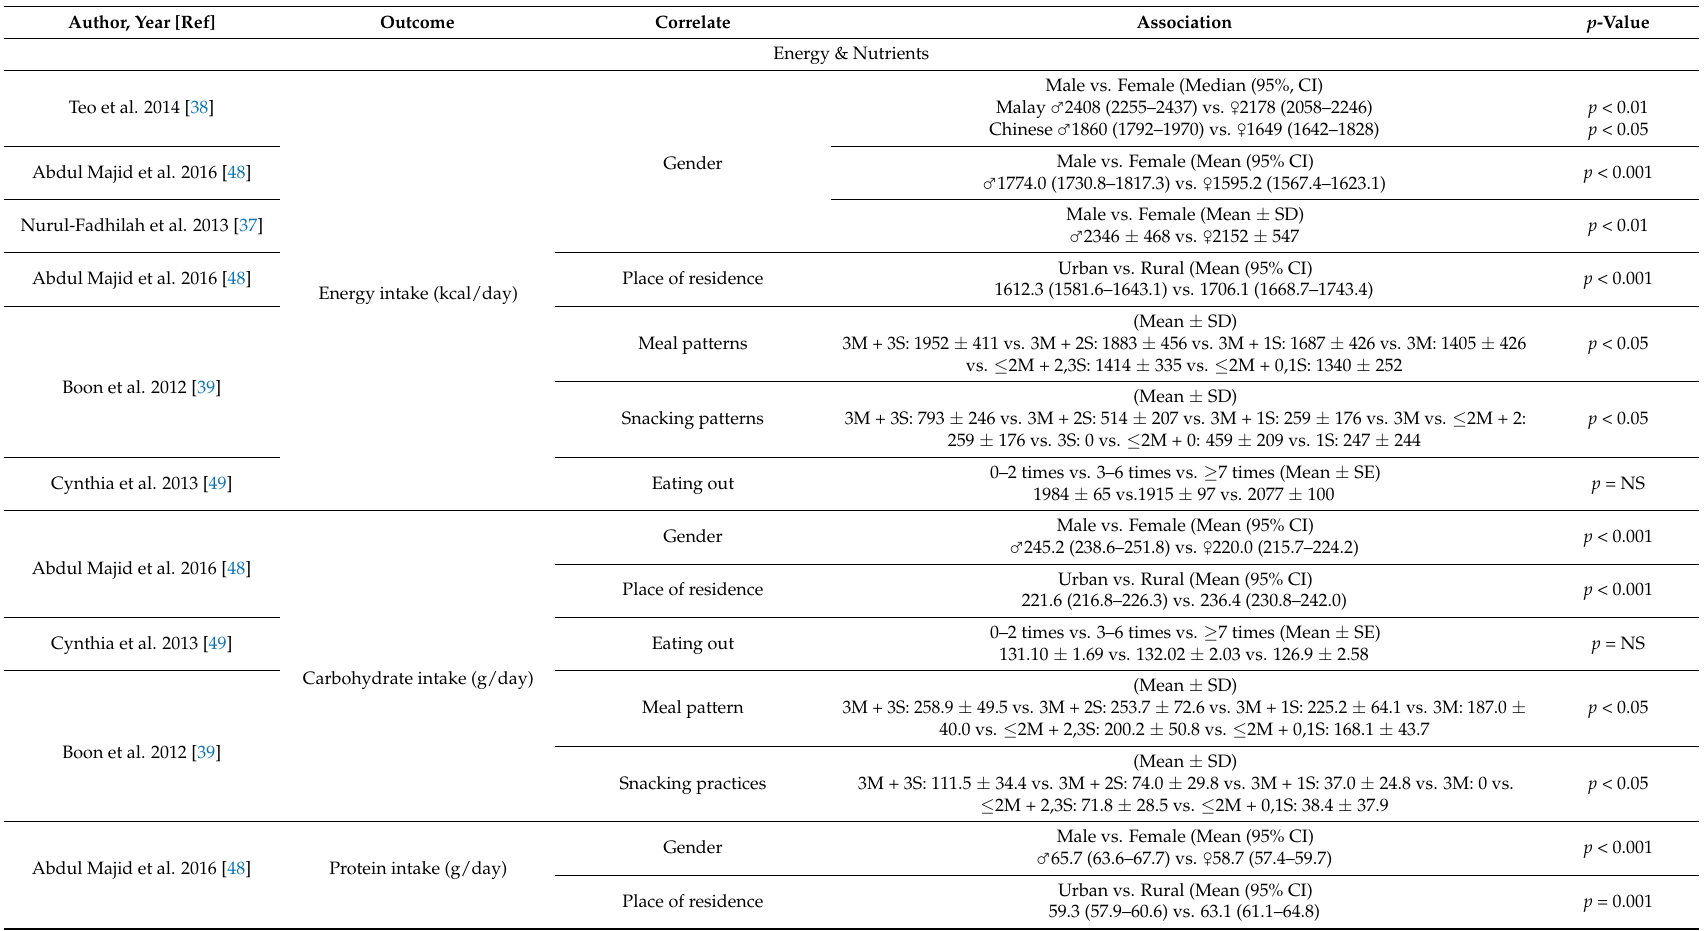
Table 2. Summary of associations between the determinants of diet and dietary